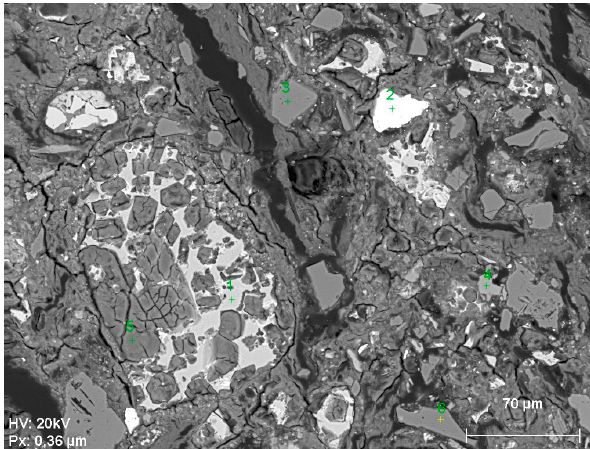
Figure A1. BSE photo of the sample along with EDS analysis locations.